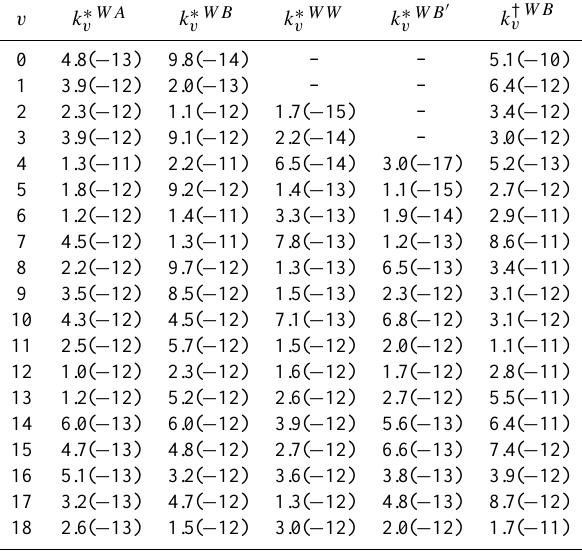
Table 3. Applied rate coefficients in Eq. (8c).